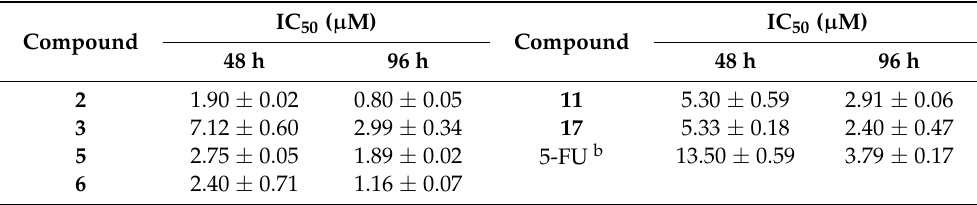
Table 2. Cytotoxic effects of 1 – 19 against HCT-116 cells a